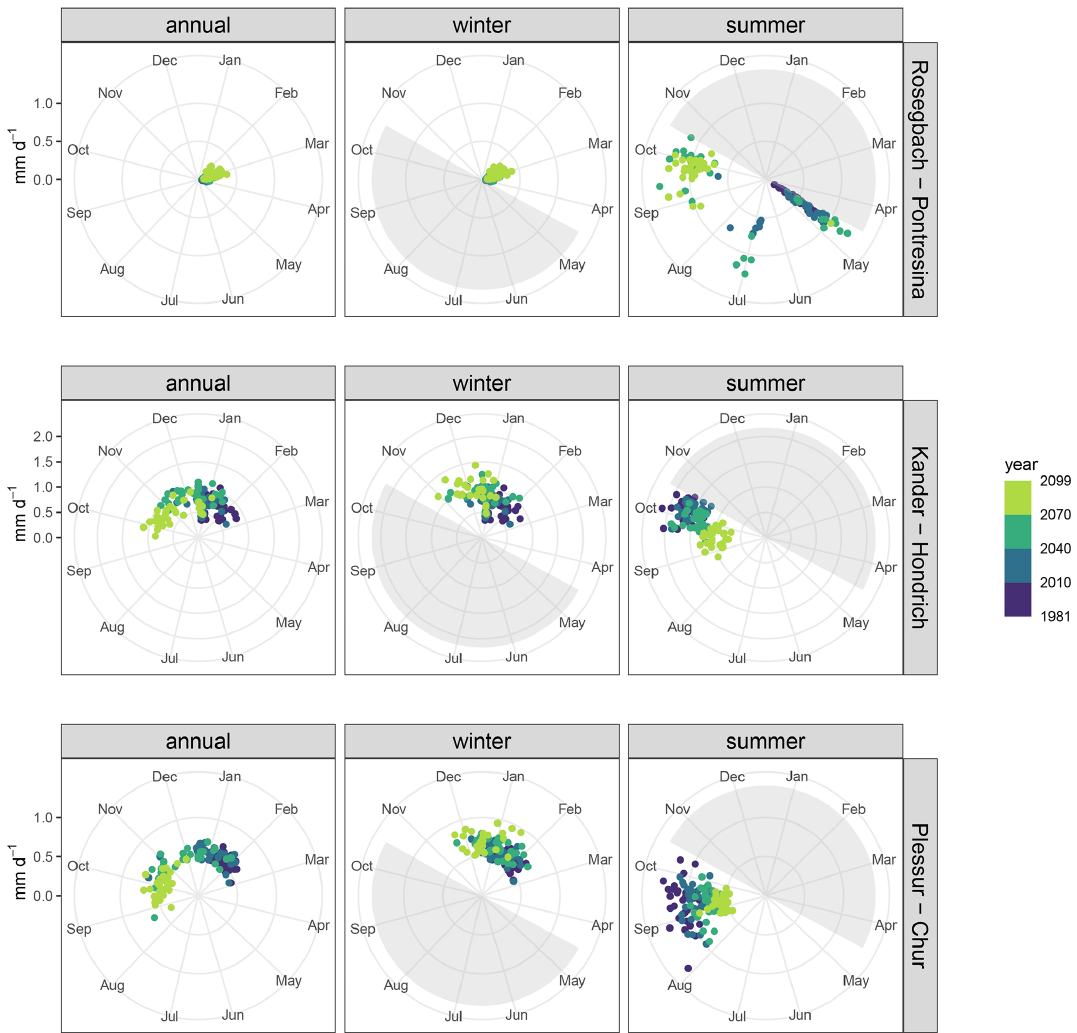
Figure 4. Multimodel median of magnitude and seasonality of low flows and seasonal low flows in Alpine catchments: Rosegbach (top row panels), Kander (middle row panels), and Plessur (bottom row panels). Table 2. Relative changes (in\%˜) by the end of the century and the seasonality (SEAS) of moderate low and high flows for the six representa- tive catchments. The seasonality indicates the season in which the moderate low and high flows generally occur. Abbreviations: Seasonality in the winter half-year in the reference period and predominantly in the summer half-year in the future period (WS), seasonality in the winter half-year in both periods (WW), seasonality in the summer half-year in the reference period and in the winter half-year in the future period (SW), and seasonality in the summer half-year in both periods